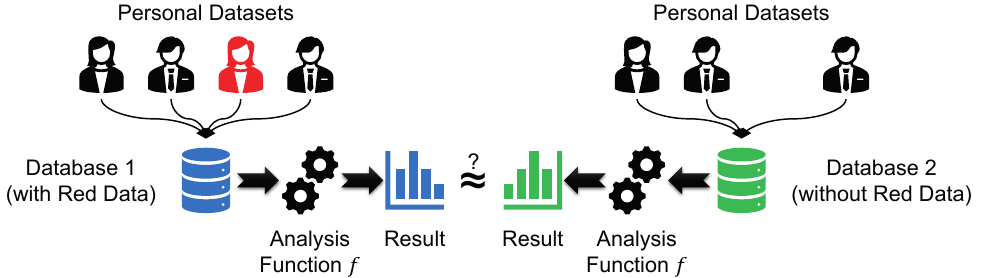
Figure 14. Simplified Representation of the Central Idea of Differential